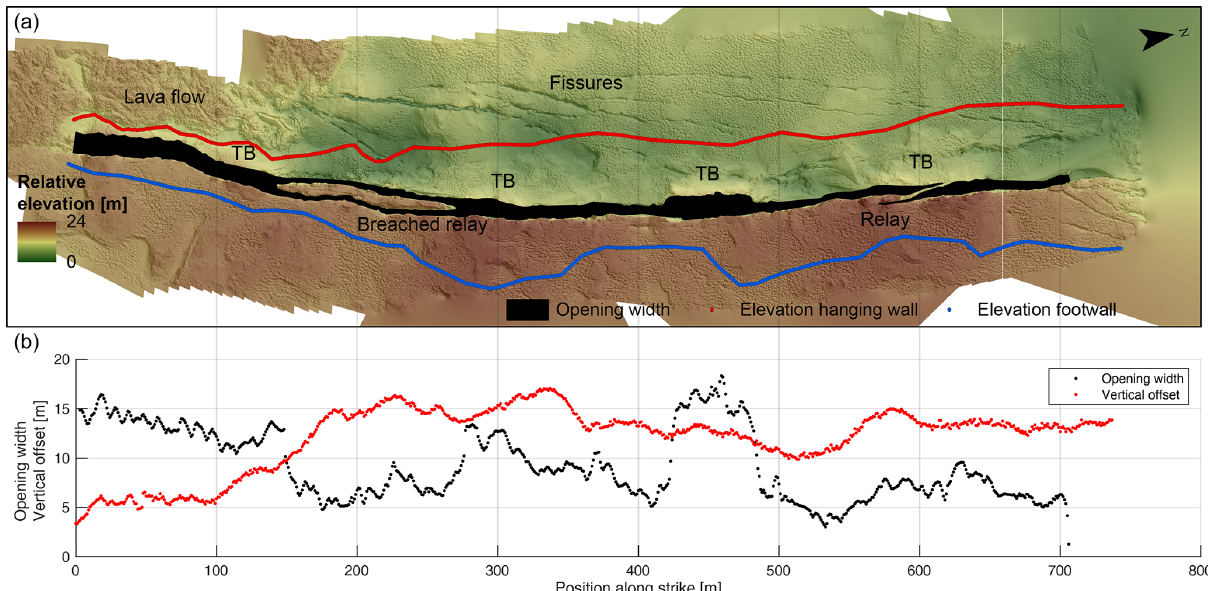
Figure 8. Fracture associated with the Krafla fissure swarm. Red dots: elevation extraction points on the hanging wall; blue dots: elevation extraction points on the footwall. (a) DEM with the mapped opening width of the fractures and elevation extraction points. (b) Opening width (black) and vertical offset (red) plotted along strike. The x -axis scale is analogous to the scale in the DEM in panel (a) ; 65 ◦ 51 (cid:48) 19 (cid:48)(cid:48) N, 16 ◦ 43 (cid:48) 21 (cid:48)(cid:48) W. Projection of the DEM: WGS1984 UTM 28N.